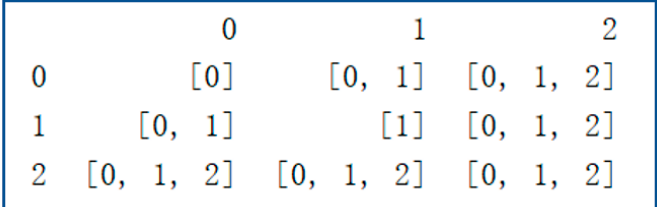
Figure 3. Top left (running result of Python).